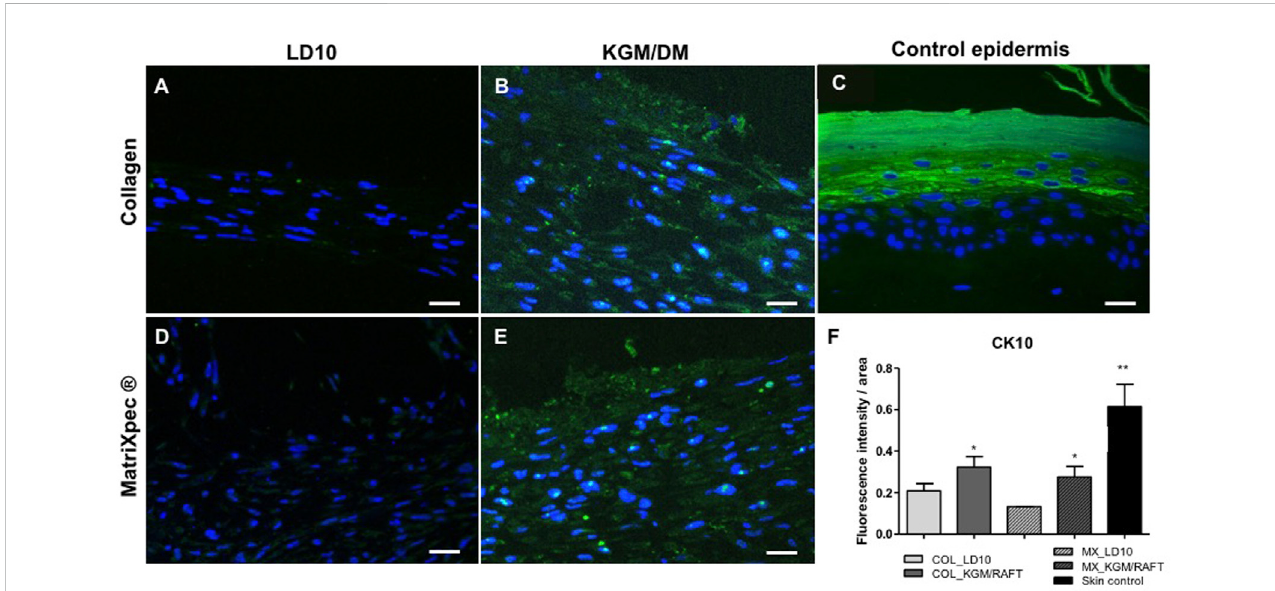
FIGURE 6 ExpressionofCK10byimmuno fl uorescence. (A,D) MSCculturedwithLD10or (B,E) KGM/DMonto (A,B) collagenor (D,E) MatriXpec ™ . (C) Skinformedby keratinocytes (control). CK10 labeling is shown in green. Nuclei are stained in blue (DAPI Magni fi cation of 200x. Scale bar: 100 µm. (F) Mean fl uorescence intensity per pixel in each group was compared to organotypic cultures formed by MSC cultivated onto collagen support with LD10 (COL_LD10). * ( p < .05) and ** ( p < .01).